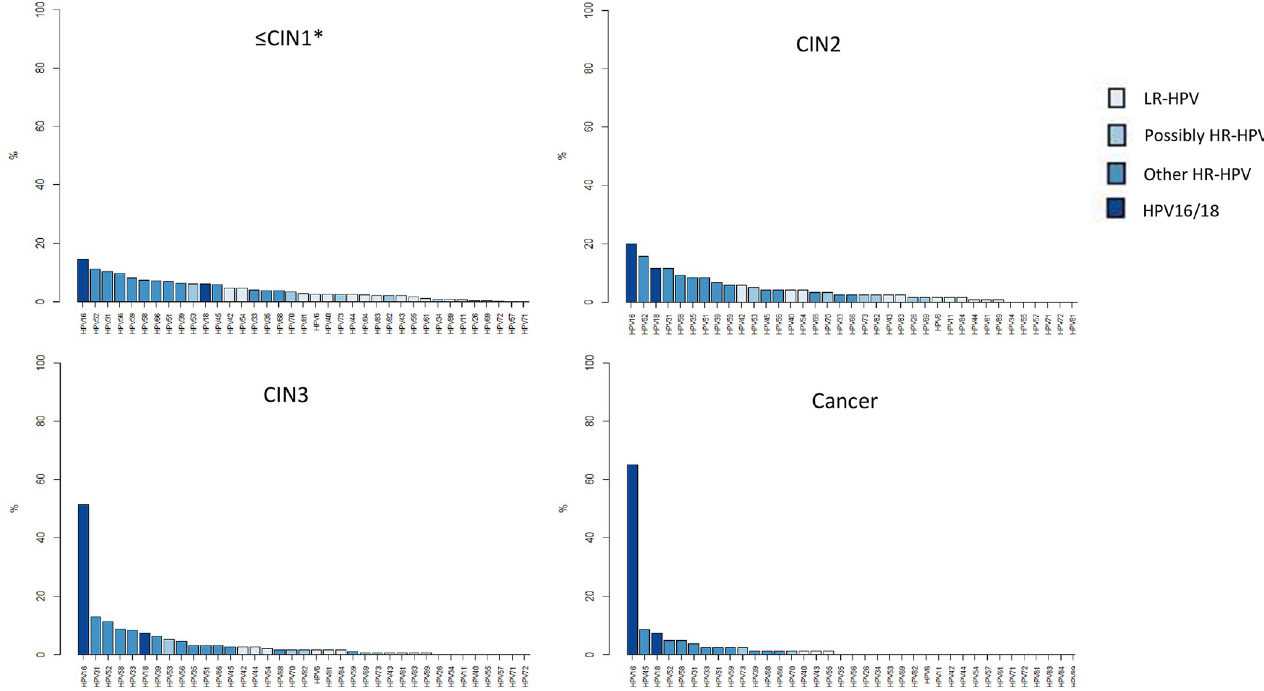
Fig 2. Distribution of HPV genotype prevalence within histological diagnoses in HPV screened positive women. Prevalence (%) shown as bars within each histological group. Colours represent different HPV genotypes risk-based groups: (1) HPV16/18 (carcinogenic types), (2) other HR-HPV (including other carcinogenic HPV31/33/35/39/45/51/52/56/58/59 types, probably carcinogenic HPV68 type and possibly carcinogenic HPV66 type; all twelve of them in the HPV screening techniques cocktails); (3) possibly HR-HPV (including other possibly carcinogenic HPV26/ 34/53/69/70/73/82 types), (4) LR-HPV (including low-risk HPV6/11/40/42/43/44/54/55/57/61/71/72/81/83/84/89 types) and (5) negative (none of the genotypes detected).